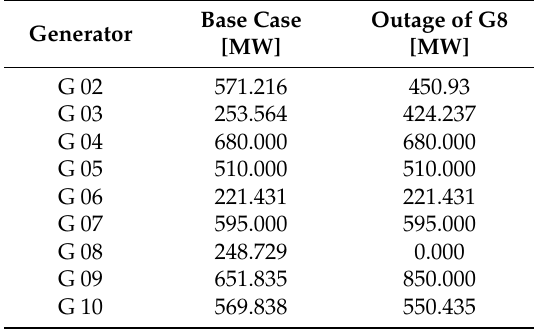
Figure 10. Maximum loadability of elements after outage of G8, with the new economic re-dispatch algorithm. Table 5. Economic re-dispatch values after the outage of generator G8.